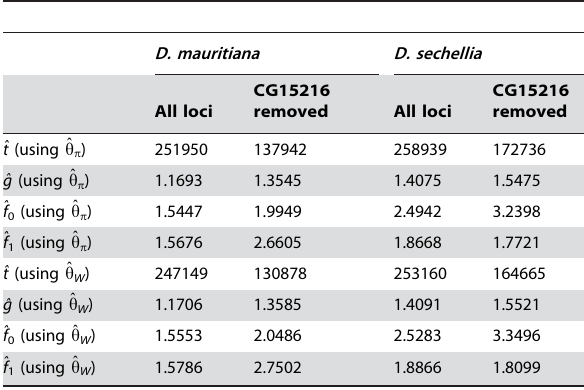
Table 5. Estimates of t , g , f 0 and f 1 using the 4-parameter model.